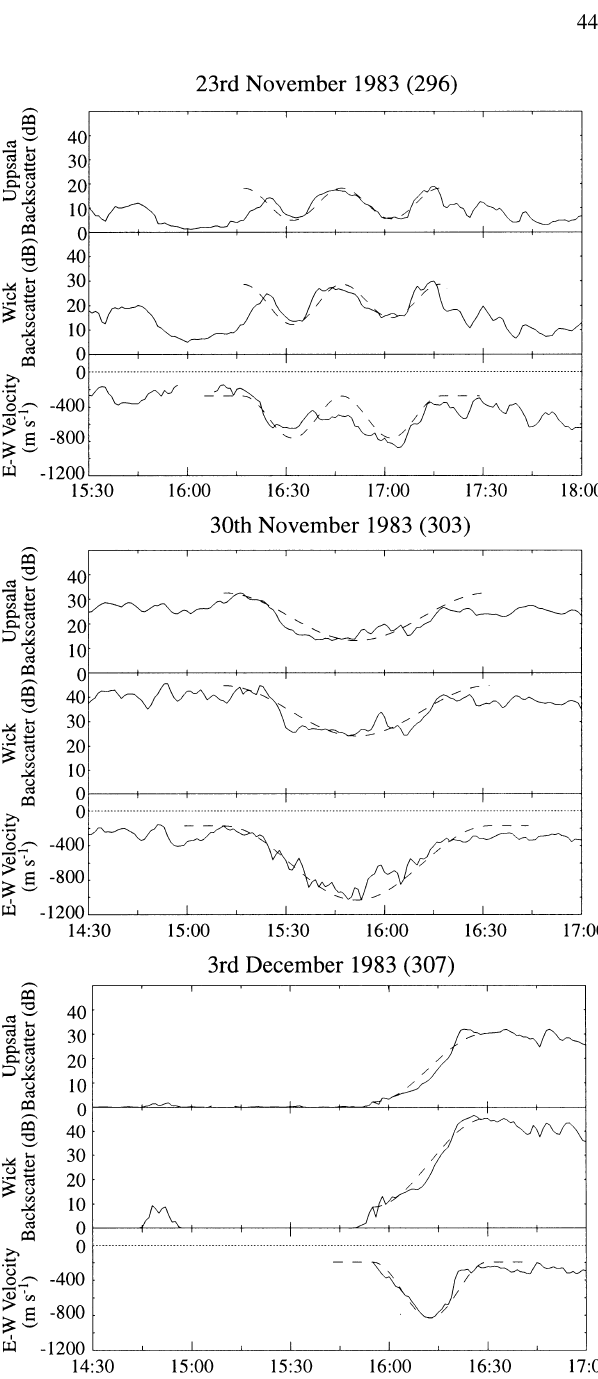
Fig. 3. Three examples of the backscatter intensity and east-west velocity variations during SARAS events. The dotted line in each panel depicts the function form of the idealised function employed by the selection algorithm to locate